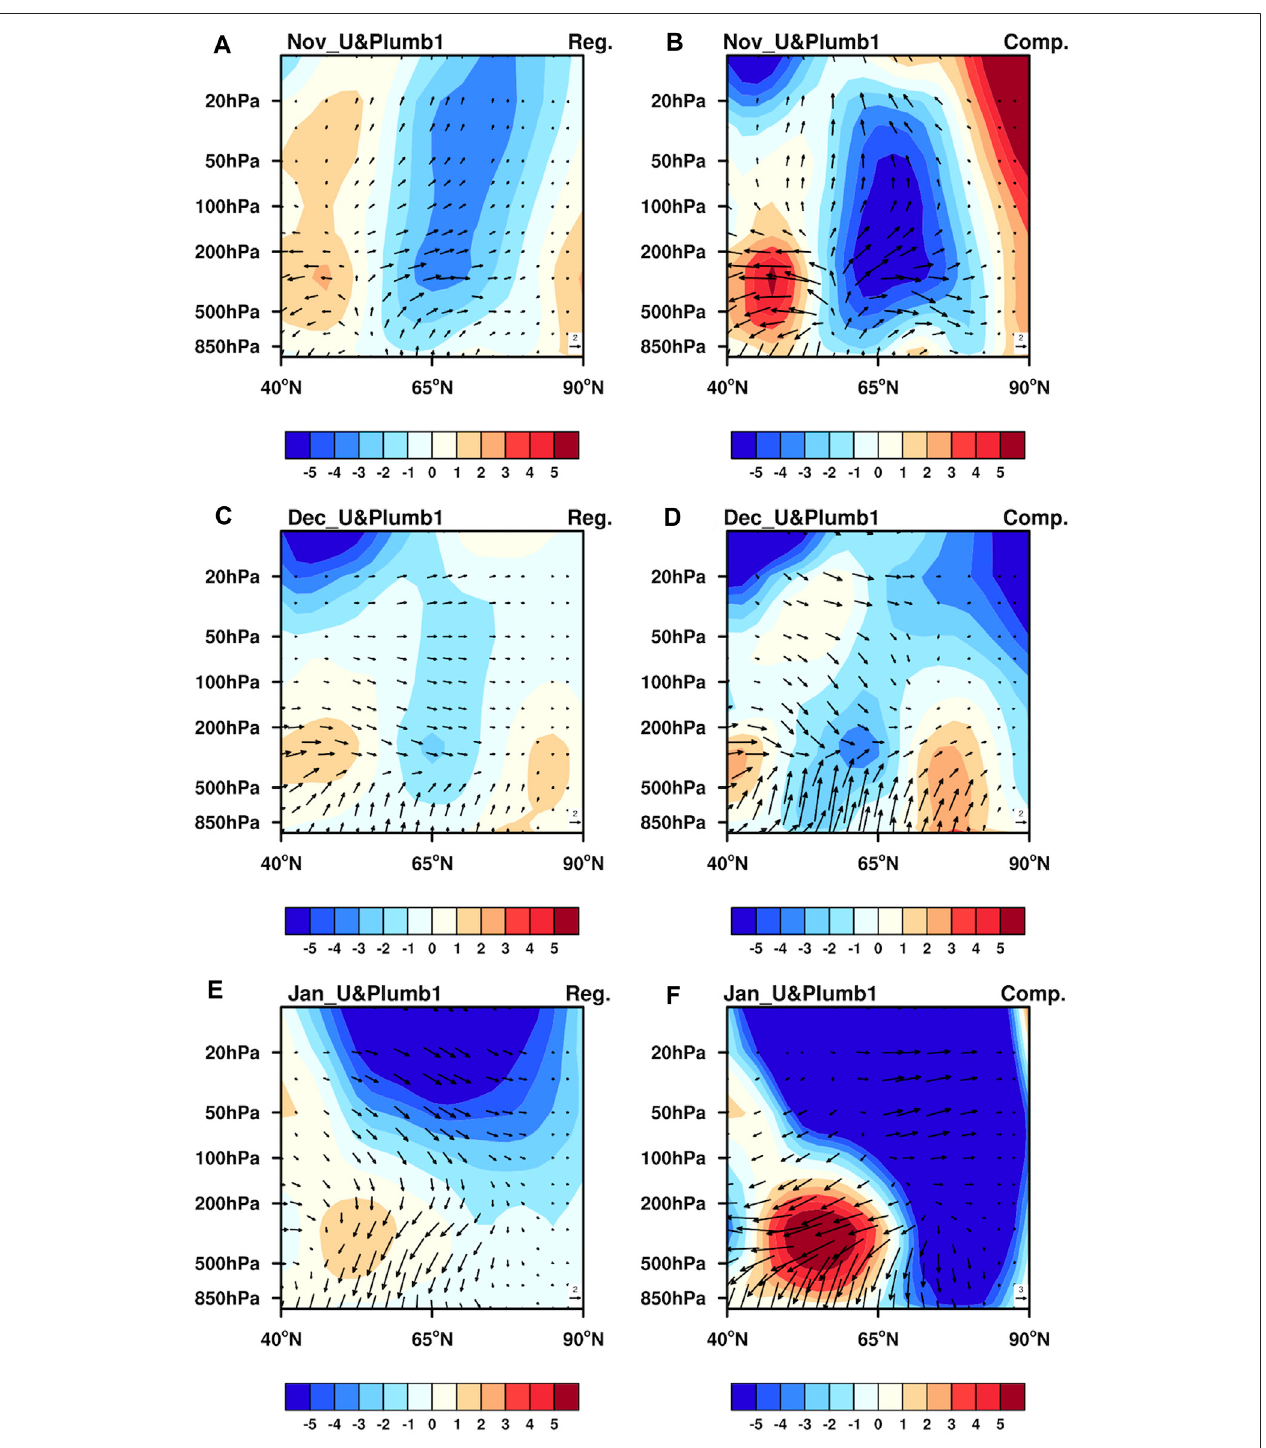
FIGURE5| (A,C,E)Regressionsofzonalwind(shading;units:m s − 1 )anomaliesandtheassociatedwavenumber-1waveactivity fl ux(WAF;vectors;units:m 2 s − 2 ) for November toJanuary on theNovemberSSDI and (B,D, F)results ofcomposite differences betweenSSD H – SHI + − and SSD L – SHI − + during2000/01 – 2018/19: (A, B) November (averaged between 65 ° E and 90 ° E); (C, D) December (averaged between 65 ° E and 90 ° E); (E, F) January (averaged between 90 ° E and 120 ° E).